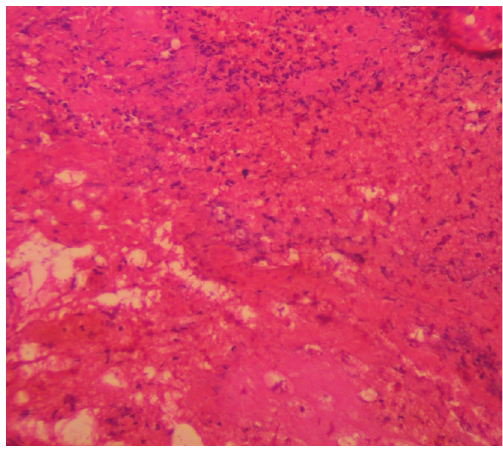
Figure 4: Surgical pathology showing inflammation.